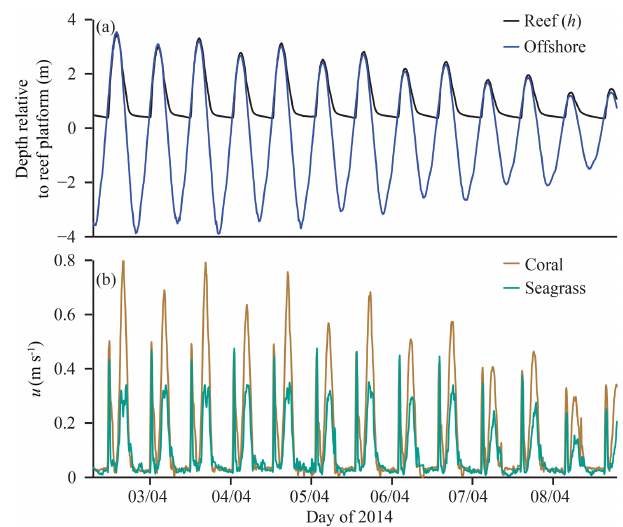
Figure 2. Selected time series of spring–neap transition showing (a) water depths ( h ) on the reef (measured in the seagrass zone) and offshore, with depth-averaged flow speed u in (b) coral- and seagrass-dominated